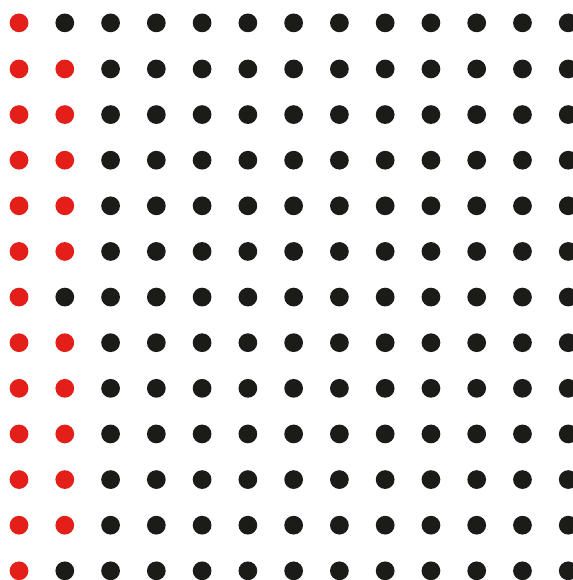
Figure 27: Schematic diagram of uplifted nodes under Songpan wave for HV case (54 nodes uplifted and uplift area ratio is 25.6%).